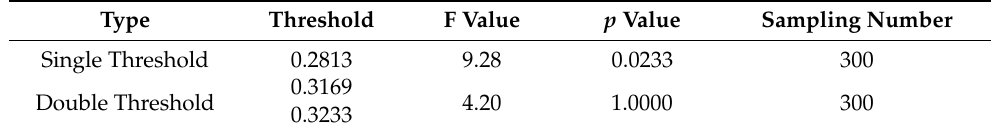
Table 7. Test of threshold effect of innovation